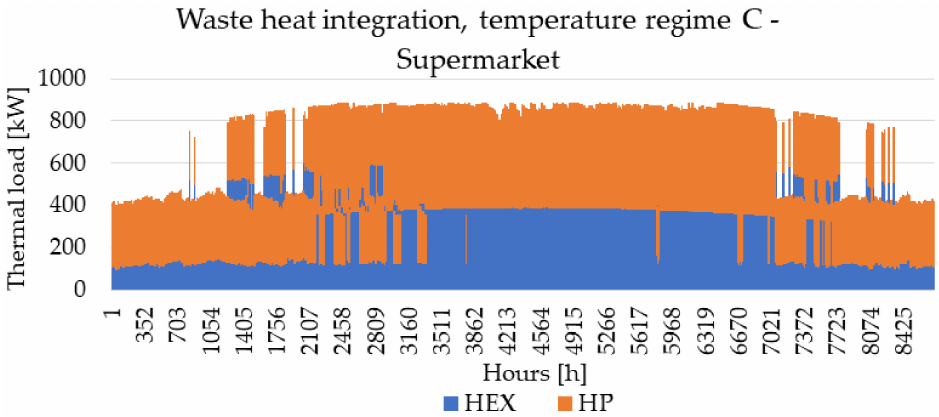
Figure A4. Waste heat utilization per technology, DH temperature regime C—supermarket.